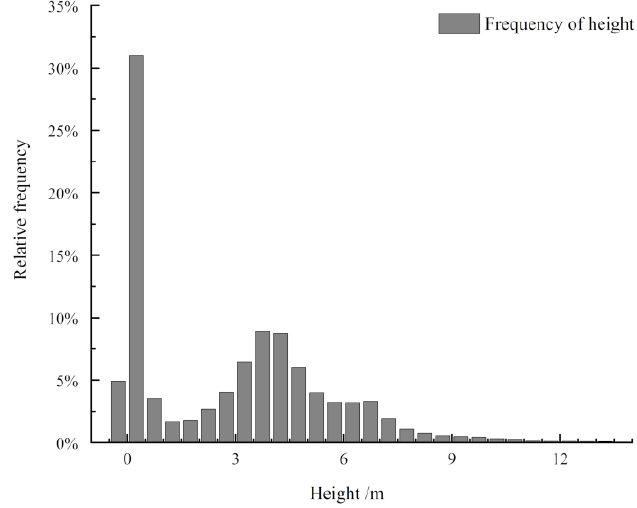
Figure 12. Frequency distribution diagram of the nDSM pixel values. Table 4. Classification rules for the vegetation and the number of building floors.